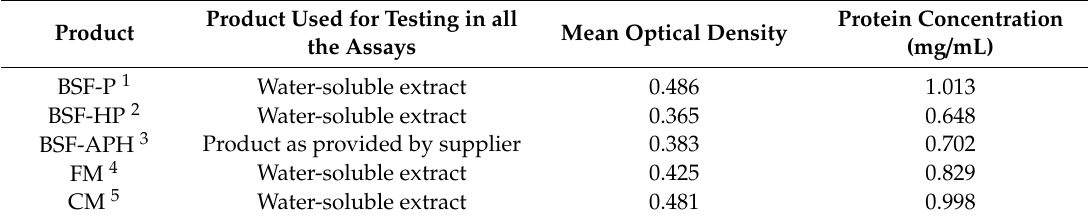
Table 3. Protein quantification using bicinchoninic acid assay.